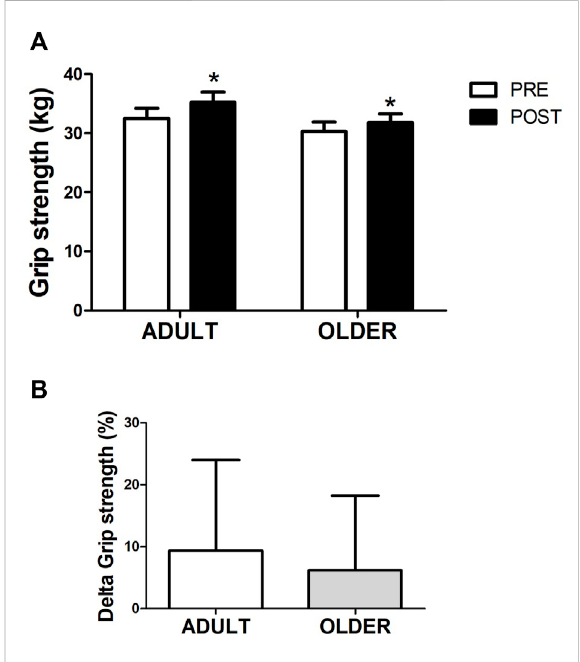
FIGURE 2 Strength through maximal handgrip strength (A) . Percentage of variation between PRE and POST in grip strength (B) is also shown. n = 22 participants in the ADULT group and n = 20 participants in the OLDER group. Data were analyzed using a repeated-measures ANOVA (A) and an independent samples t-test (B) . * p < 0.05 (time effect).